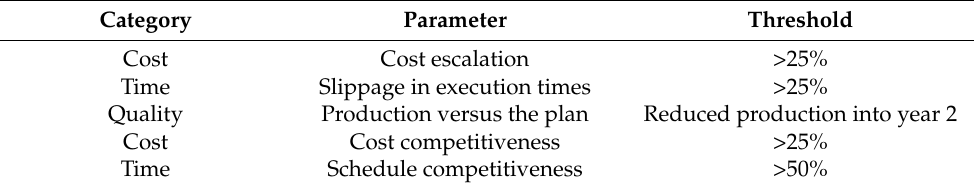
Table 1. Parameters and thresholds for megaproject evaluation.